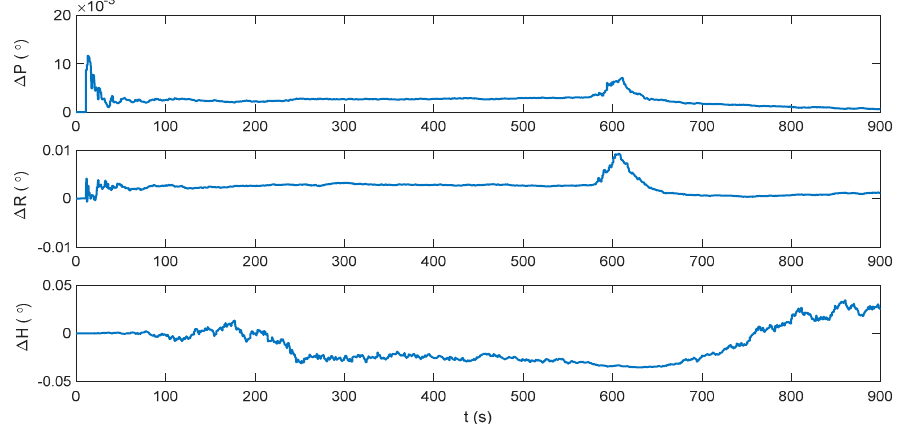
Figure 3. Attitude error of the inertial navigation system/Doppler velocity log (INS/DVL)-integrated navigation system. Sensors 2017 , 17 , 2030